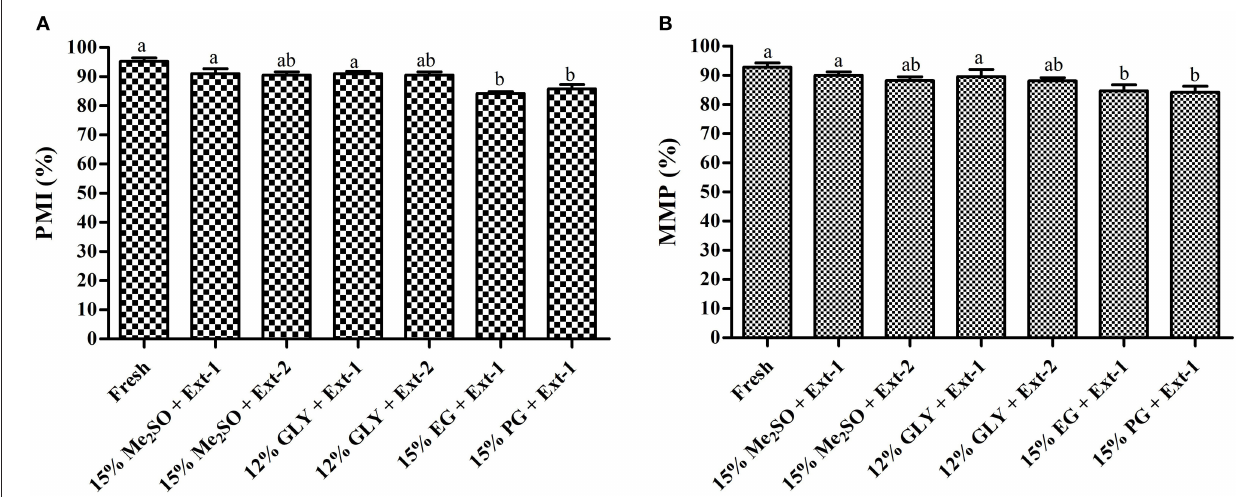
FIGURE 5 | Plasma membrane integrity (%) and mitochondrial membrane potentials (%) of post-thaw marbled flounder sperm ( n = 3). Significant different levels ( p < 0.05) are denoted by different letters. (A) Plasma membrane integrity of cryopreserved sperm, (B) Mitochondrial membrane potentials of cryopreserved sperm.